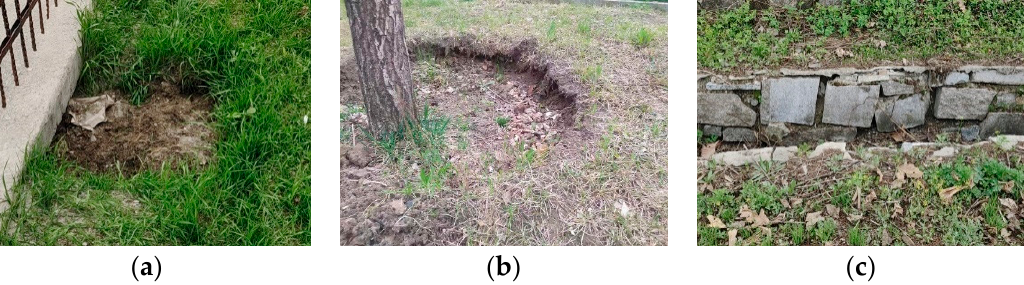
Figure 13. Typical negative obstacle scenario. ( a ) 40 cm × 40 cm; ( b ) 100 cm × 40 cm; ( c ) 120 cm × 60 cm.